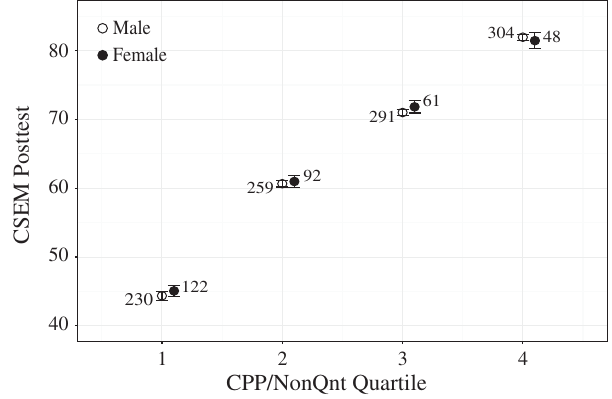
FIG. 6. CPP/NonQnt vs CSEM pretest score.